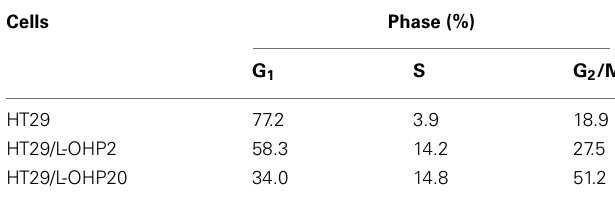
Table 2 | Cell cycle of L-OHP-resistant HT29